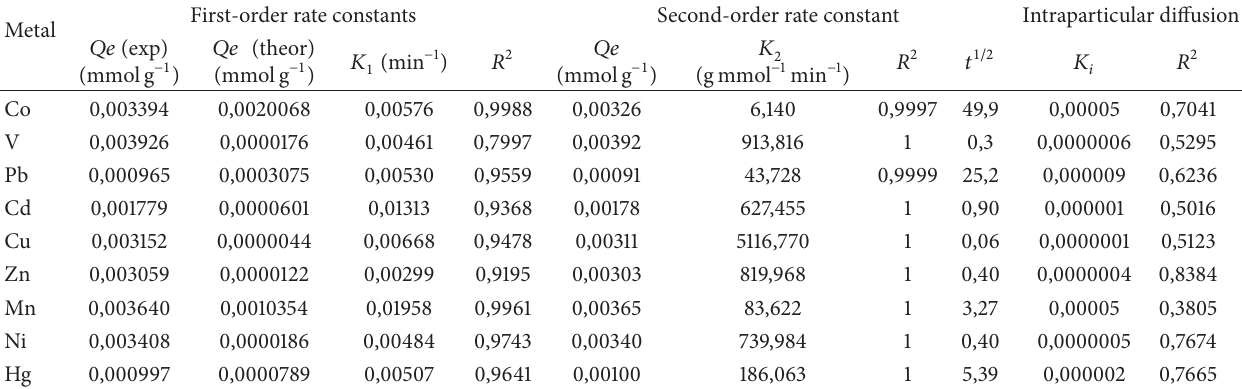
Table 2: Adsorption kinetics of metals in single-metal